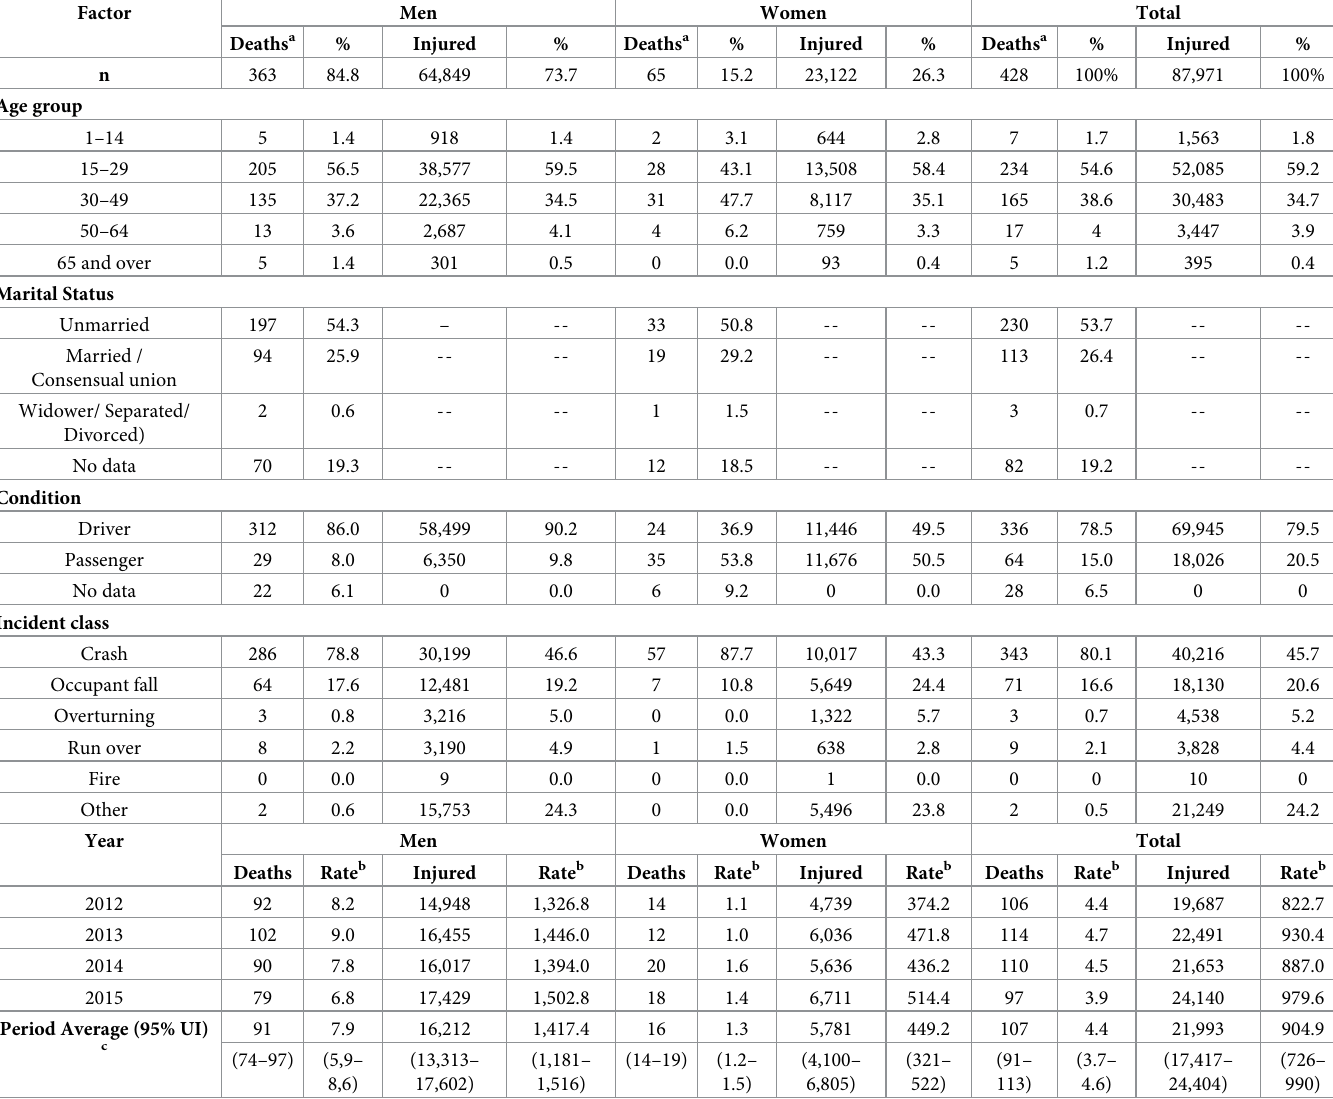
Table 1. Frequencies of motorcyclist road incidents-deaths and injuries-according to characteristics of the person, time and circumstance by sex.